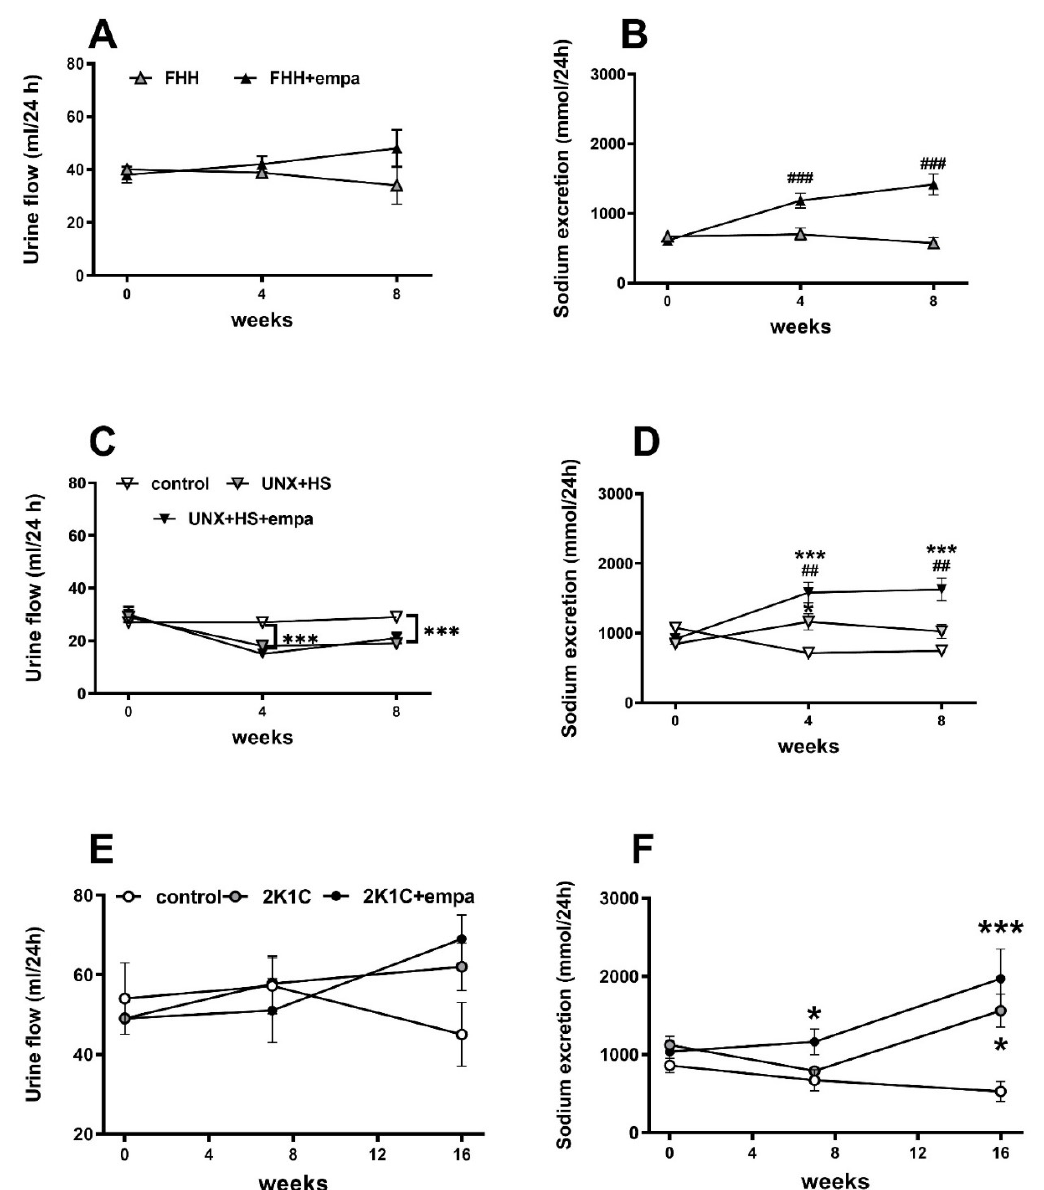
Figure 3. The effect of empagliflozin treatment on diuresis ( A , C , E ) and sodium excretion ( B , D , F ) in fawn-hooded hypertensive (FHH) rats ( A , B ), uninephrectomized (UNX) Hannover Sprague Dawley (HanSD) rats on high-salt (HS) diet ( C , D ), and Wistar rats subjected to renal artery stenosis (Goldblatt 2K1C hypertension) ( E , F ). * p < 0.05 vs. control group, # p < 0.05 vs. untreated group. * denotes p < 0.05; ## denotes p < 0.01; and ### and *** denotes p < 0.001; data are means ± SEM. Proteinuria increased in all three CKD models during the study (Figure 4). Unexpect- edly, empagliflozin treatment not only did not prevent the increase in proteinuria in CKD models but even enhanced it, with this effect being statistically significant in FHH rats. In line with this finding, the plasma urea level was increased in this particular rat strain at the end of the study. In contrast, similar values of plasma urea were found in HanSD-UNX + HS, with a profound increase in this particular rat strain at week 4 and lower values in empagliflozin-treated 2K1C Wistar